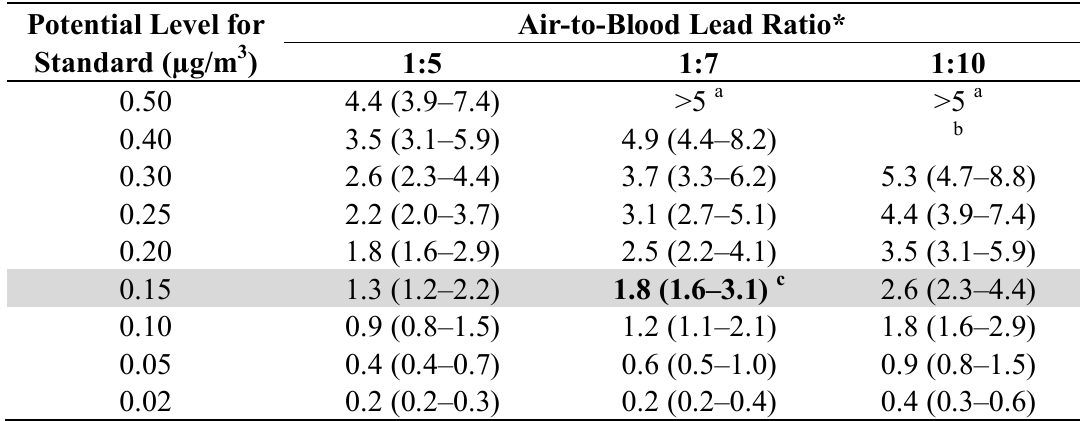
Table 1. Expected mean IQ loss estimates for children exposed at the level of the